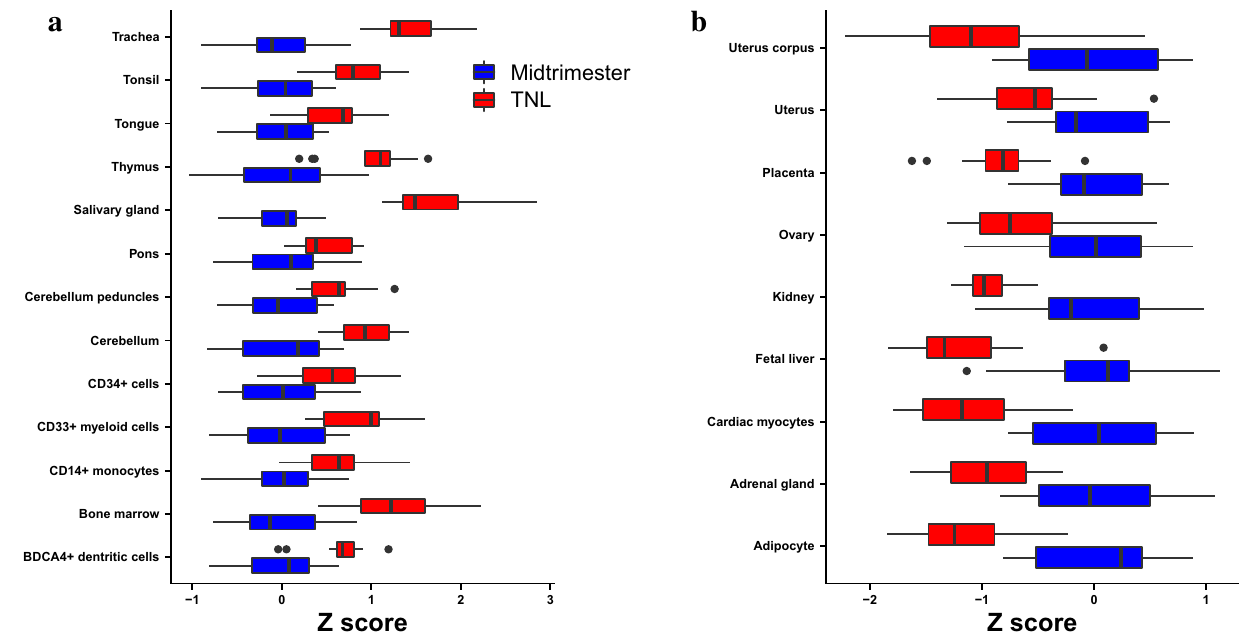
Figure 6. Expression of tissue-specific signatures. For each tissue, the expression of proteins coded by up to the 20 most preferentially expressed genes according to the GNF Gene Expression Atlas was transformed into a Z-score and averaged. The Z-scores were compared between term and midtrimester samples. Tissues with significantly (q-value < 0.05) ( a ) increased and ( b ) decreased expression at term not in labor (TNL) compared to midtrimester are shown.The box plots were created in R 115